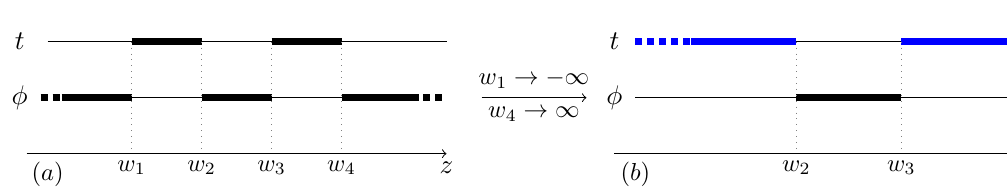
Figure 5 . ( a ) Rod diagram for the Bach-Weyl static binary black hole configuration [14]. The thick timelike rods represent the two black hole horizons. By sending the rod endpoints w 1 w w w 4 → ∞ , with 2 and 3 fixed, we recover the same diagram as in the bubble of nothing figure 3(b). This limit makes the two black holes infinitely large, while keeping the separation between them finite, as is illustrated in panel ( b )